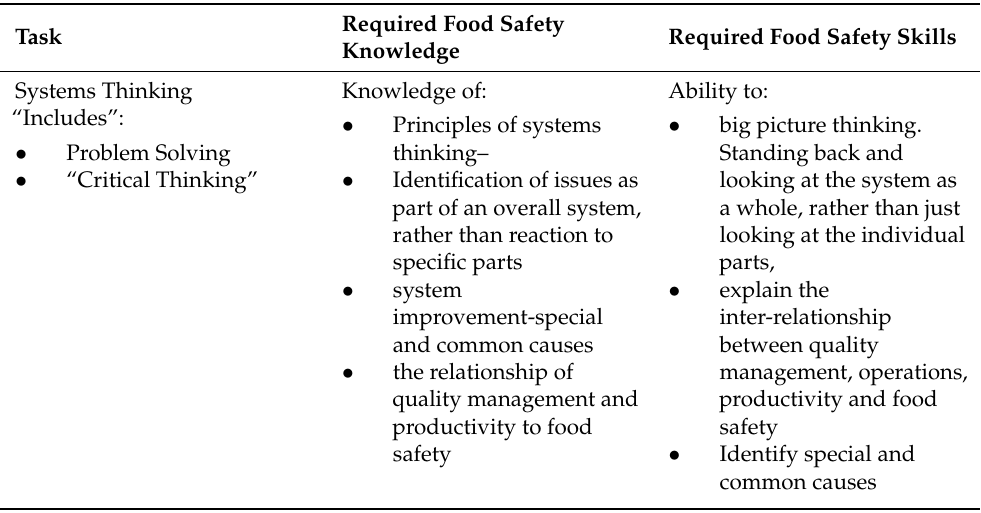
Table 3. Food safety competencies along with required safety knowledge and food safety skills and systems thinking approach Source: Adapted from “GFSI Food Safety Auditor Competencies